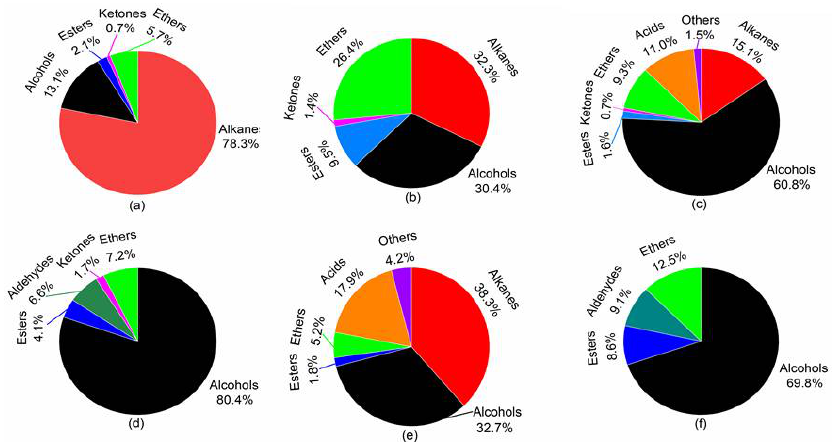
Figure 2. The VVOC compositions and their percentage content of WB-MDF. ( a ) day 1; ( b ) day 3; ( c ) day 7; ( d ) day 14; ( e ) day 21; ( f ) day 28 .